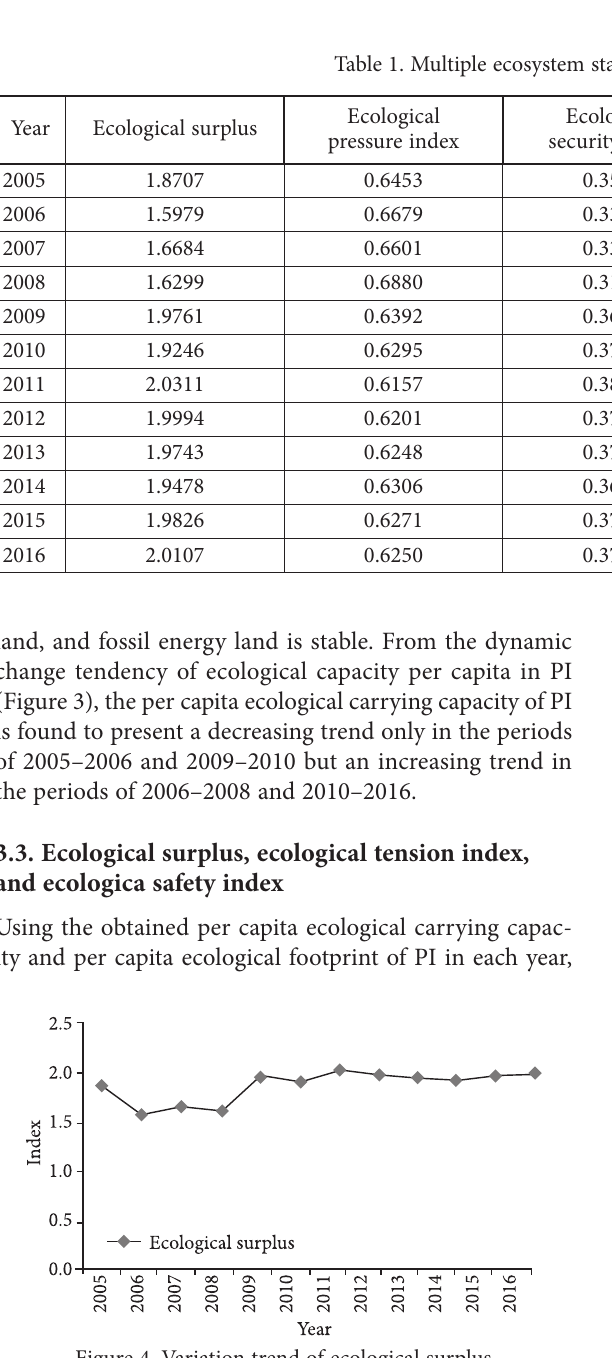
Figure 4. Variation trend of ecological surplus